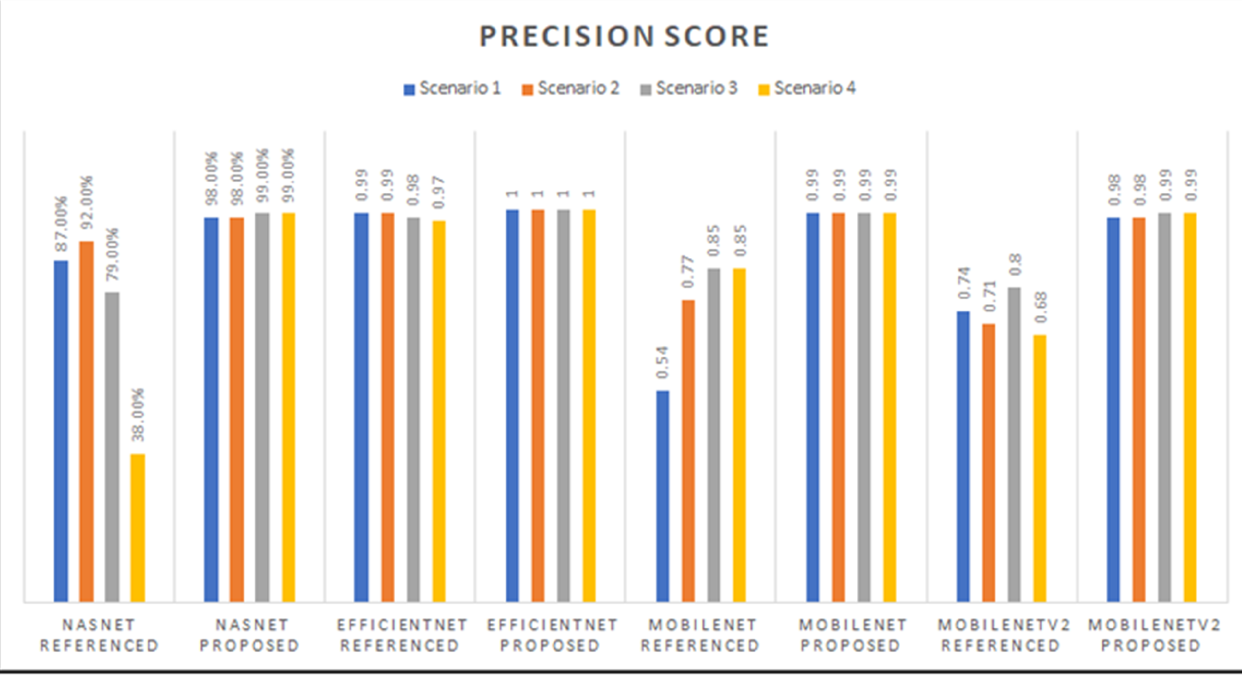
Figure 13. Graphed results of precision score for all models developed.